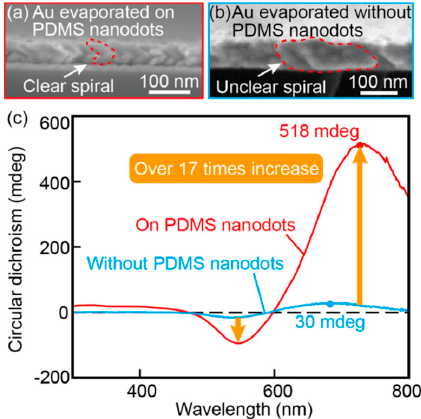
Figure 9. SEM images showing that the PDMS periodic nanodot template is important for the formation of fine Au nanospiral structures. When focusing on the circular dichroism, the condition with a template produced a peak that was 17 times larger than that for the condition without a template. ( a ) SEM image of a side view of the right-handed Au nanospiral structures evaporated on a PDMS nanodot template. ( b ) SEM image of a side view of the right-handed Au nanospiral structures evaporated without a template. ( c ) Circular dichroism spectra of the two cases with and without the